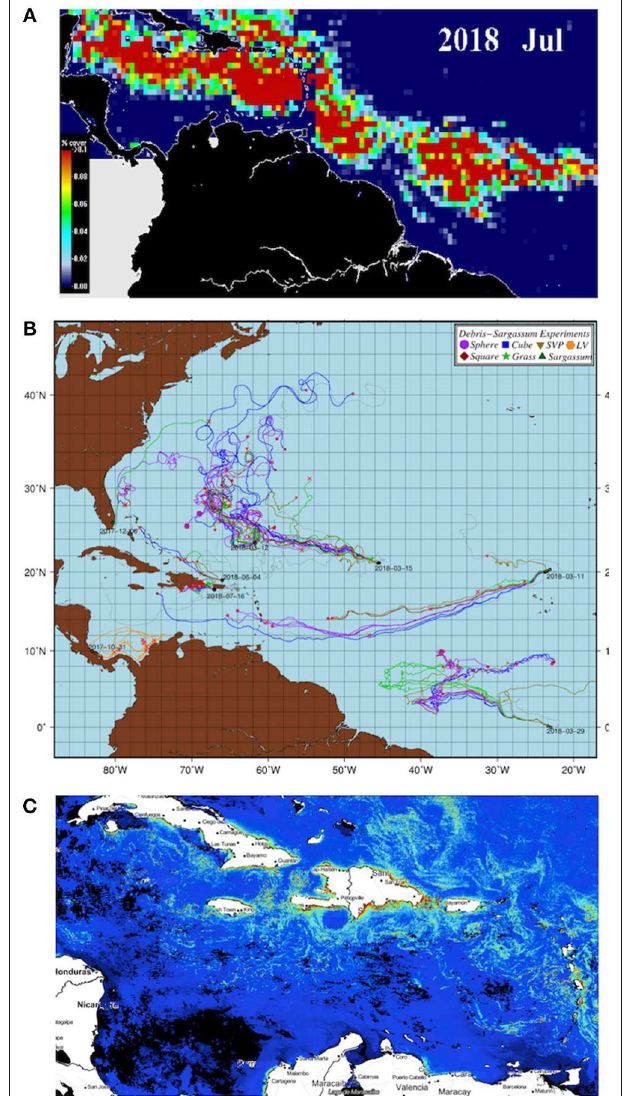
FIGURE 2 | Tracking of pelagic Sargassum density and movement in the Caribbean region. (A) Sargassum area density map (0.5 ◦ × 0.5 ◦ ) in July 2018. The red color indicate pixels where the area density (% cover) exceeds 0.1 units. (B) Trajectories of spatial drifters deployed by NOAA/AOML in the Atlantic. Each color represents a type of drifter. The trajectories of drifters with transmitters attached to real and artificial Sargassum are shown in green. (C) Cumulative weekly AFAI field from VIIRS&MODIS (20 June 2018). The structures in green/red may correspond to Sargassum patches, which extended over large areas in the Caribbean Sea during that period. Clouds are masked to